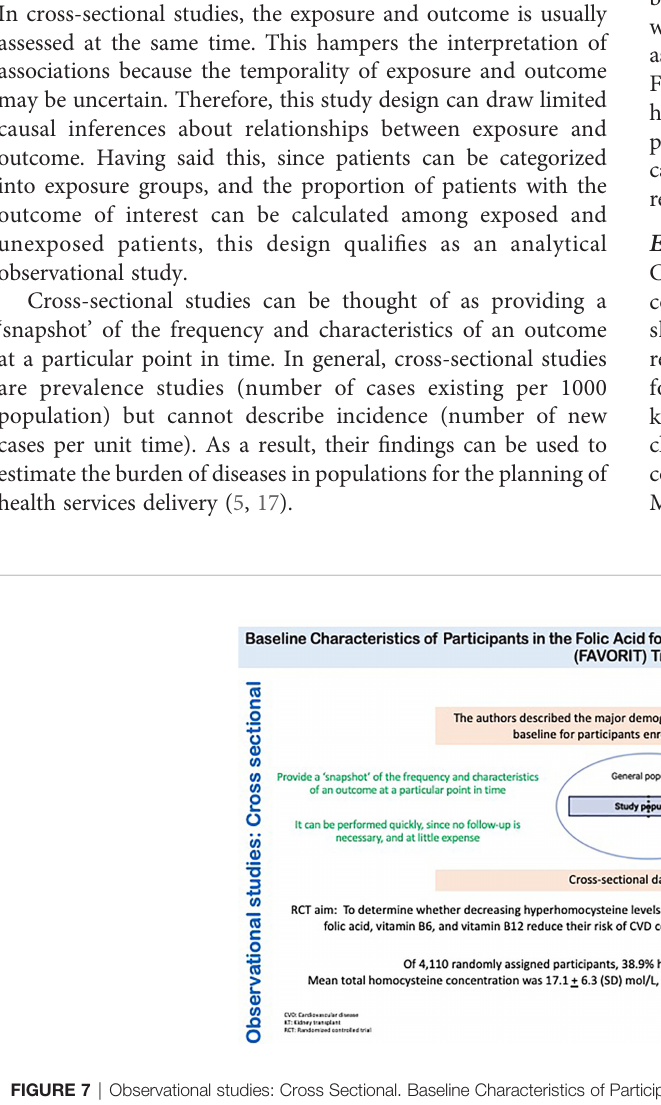
FIGURE 7 | Observational studies: Cross Sectional. Baseline Characteristics of Participants in the Folic Acid for Vascular Outcome Reduction in Transplantation (FAVORIT)